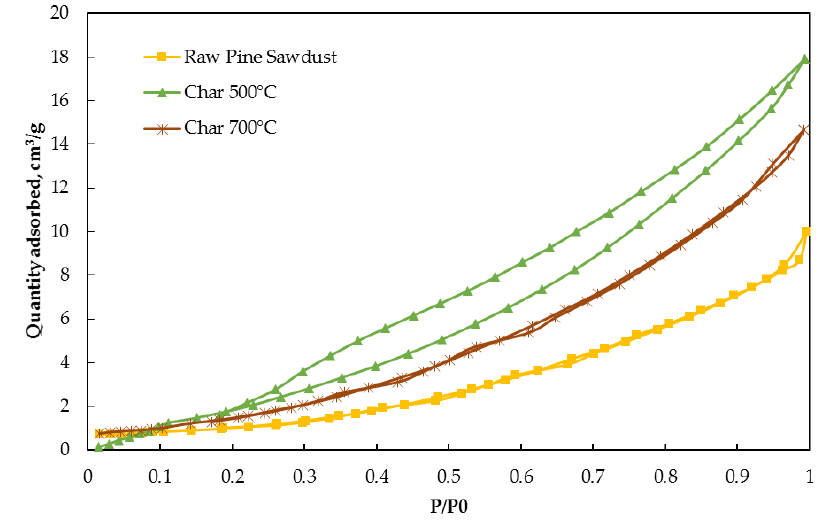
Figure 8. N 2 adsorption isotherms of raw biomass and obtained biochars.